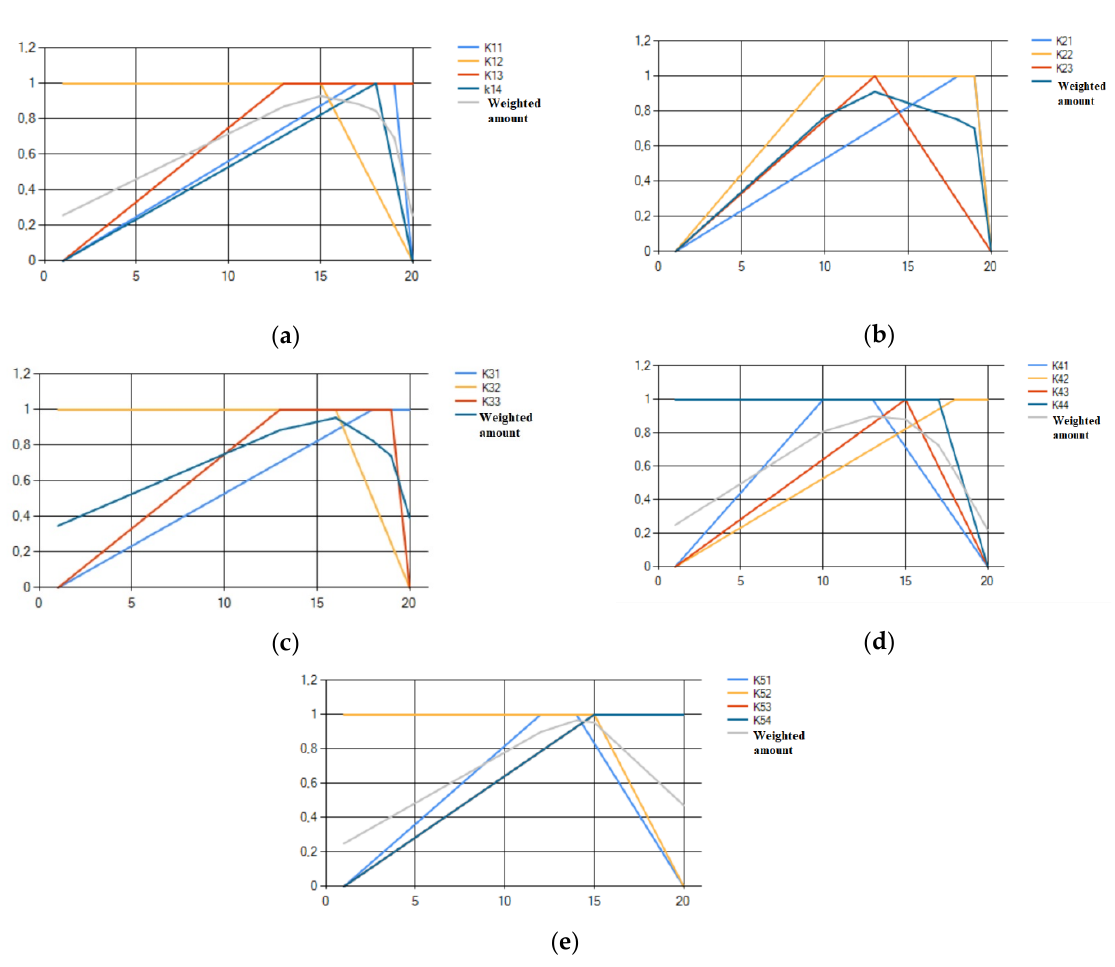
Figure 3. The result of the calculation of the project p_1 according to the model M P : ( a ) the weighted amount for a group of criteria C 1 ; ( b ) the weighted amount for a group of criteria C 2 ; ( c ) the weighted amount for a group of criteria C 3 ; ( d ) the weighted amount for a group of criteria C 4 ; ( e ) the weighted amount for a group of criteria C 5